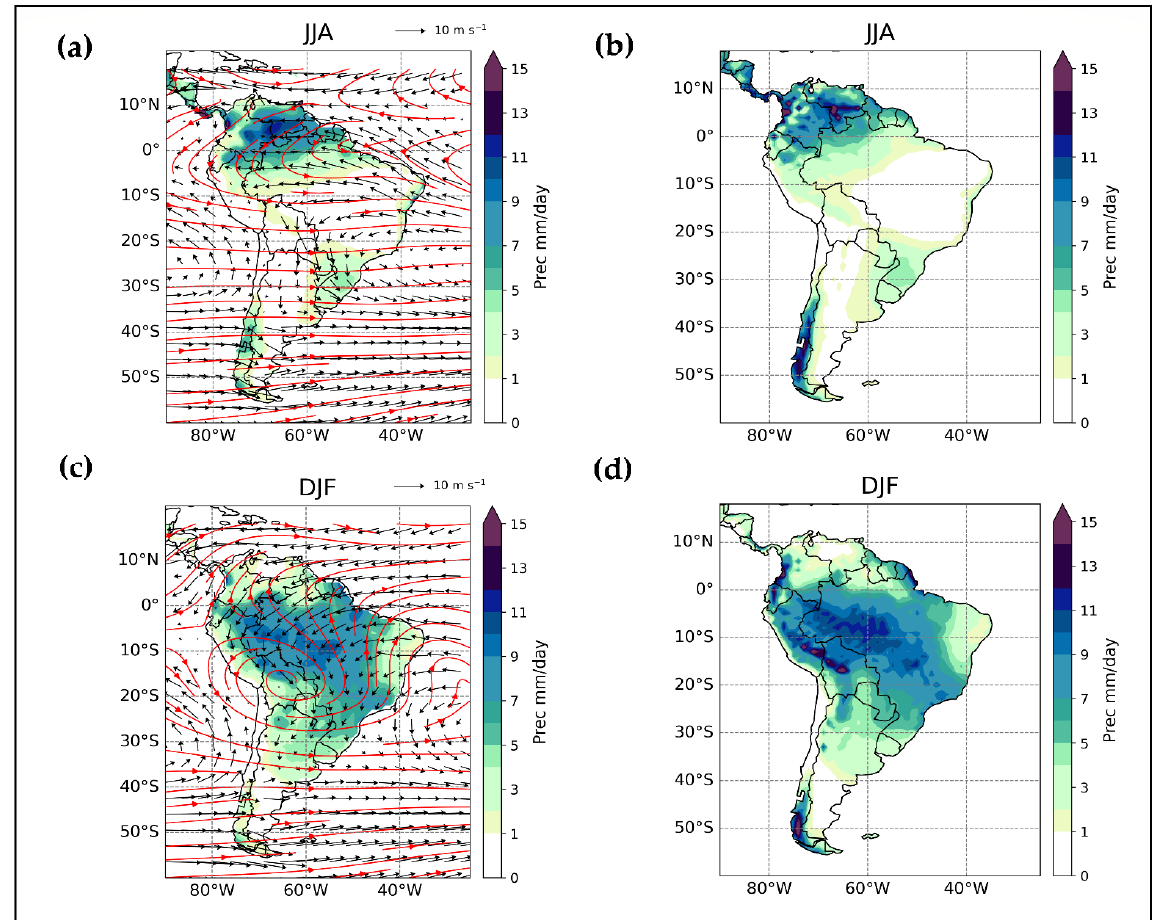
Figure 4. Mean precipitation (mm day − 1 ), wind vector (m s − 1 ) at 850 hPa, and streamlines (solid red lines) at 200 hPa in the winter (JJA) and summer (DJF) seasons for the 1993–2016 period; ( a , c ) present Climate Prediction Center (CPC) precipitation and ERA5 wind data; and ( b , d ) provide predicted rainfall from the European Centre for Medium-Range Weather Forecasts—System 5 (ECMWF-SEAS5) hindcasts.